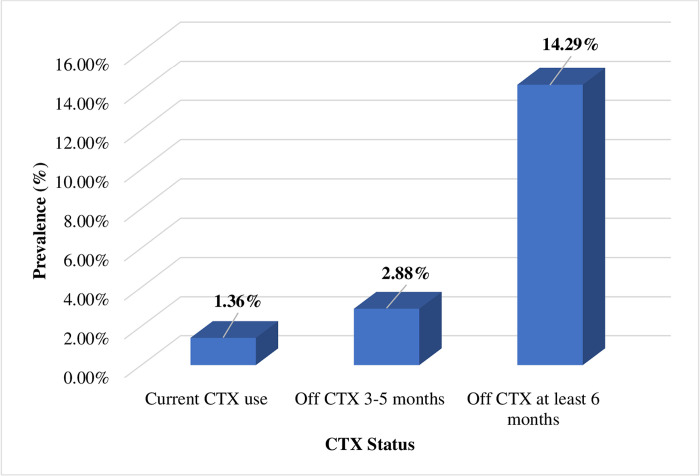
Prevalence of malaria parasitaemia stratified by cotrimoxazole status.